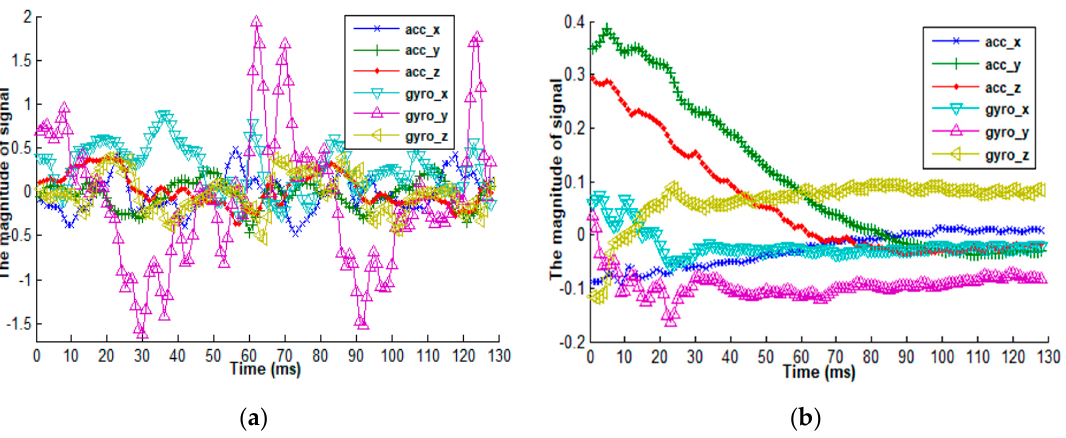
Figure 6. A comparison of the senor readings between a tri-accelerometer and a tri-gyroscope